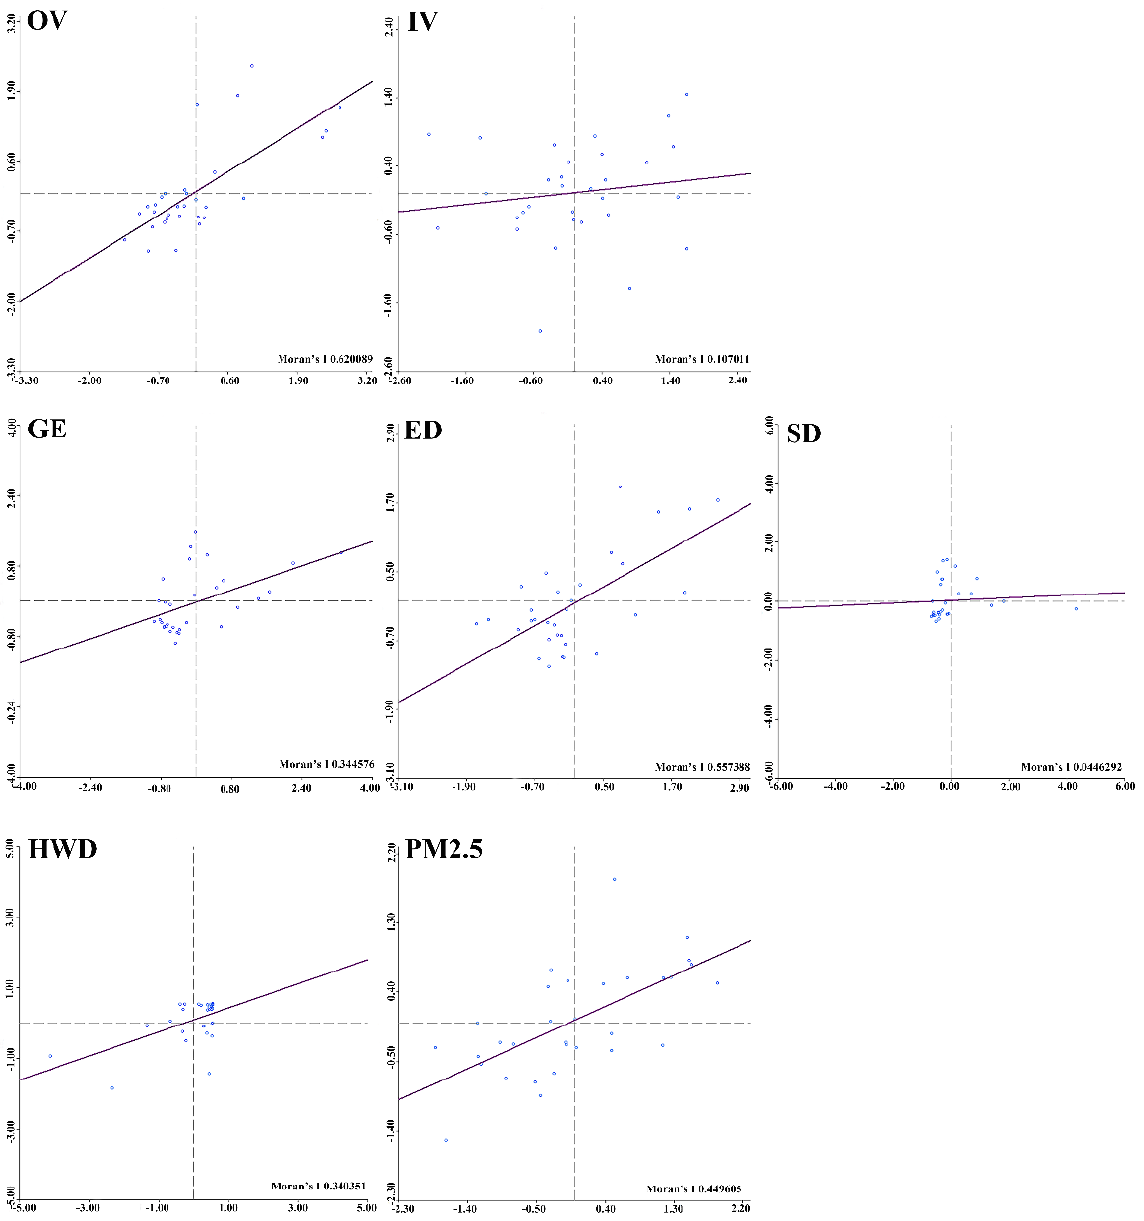
Figure 3. Local Moran’s I scatter plots 1 . 1 OV: outpatient visits per capita; IV: inpatient visits per capital; ED: effluent discharge; GE: gas emission; SD: solid discharge; PM2.5: average PM2.5 concentration; HWD: household waste disposal.